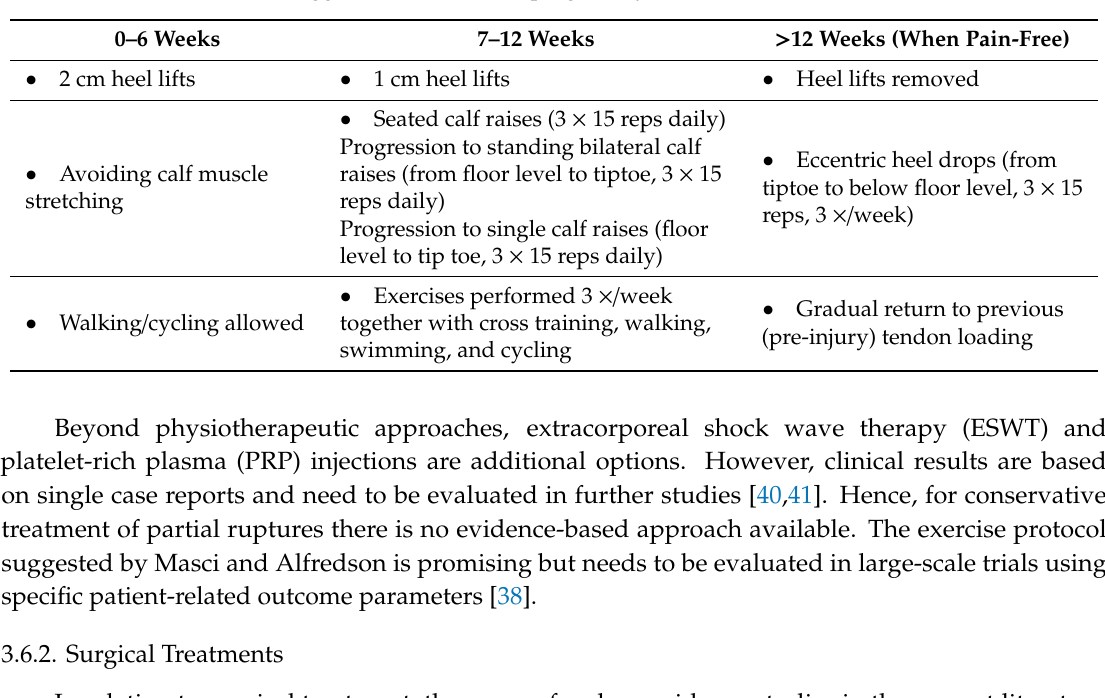
Table 1. Suggested rehabilitation program by Masci and Alfredson